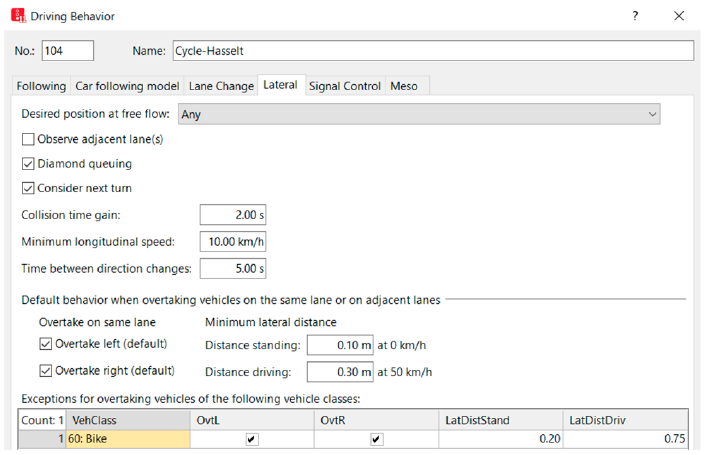
Figure 3. Adapted lateral behavior for cyclists.